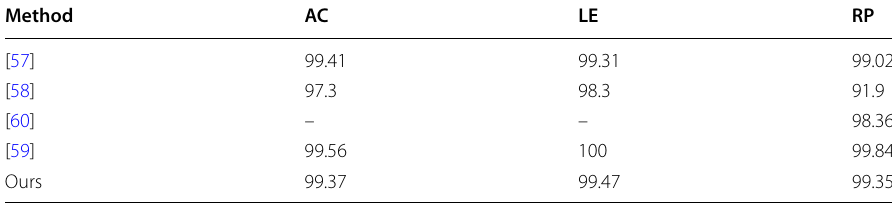
Table 3 Comparison on AOLP dataset